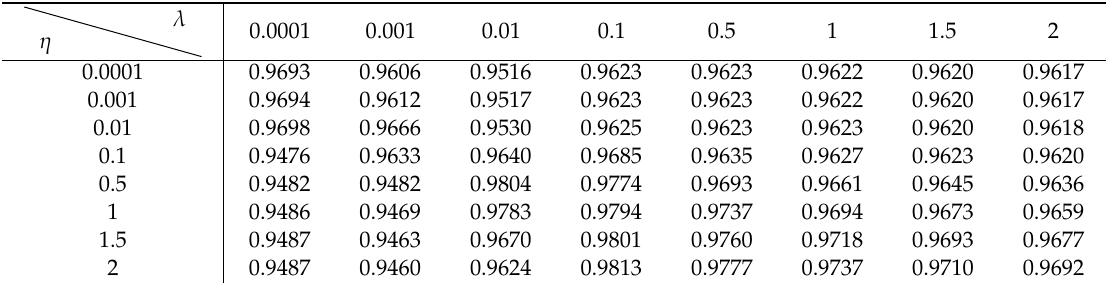
Table 1. Results with di ff erent parameters for the AVIRIS_Salinas data.